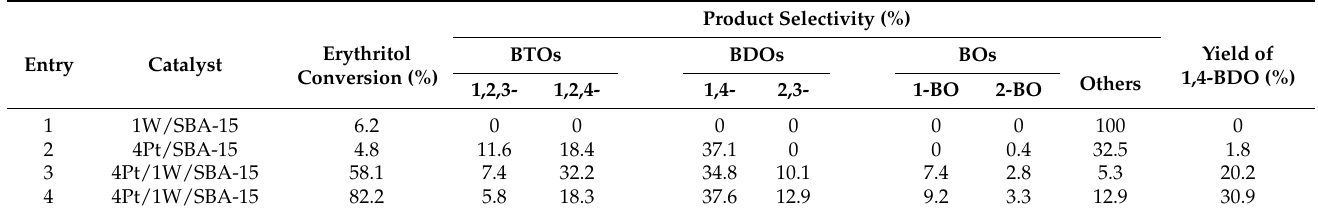
Table 2. Catalytic activity data 4Pt/1W/SBA-15 catalyst in the hydrodeoxygenation of erythritol a .